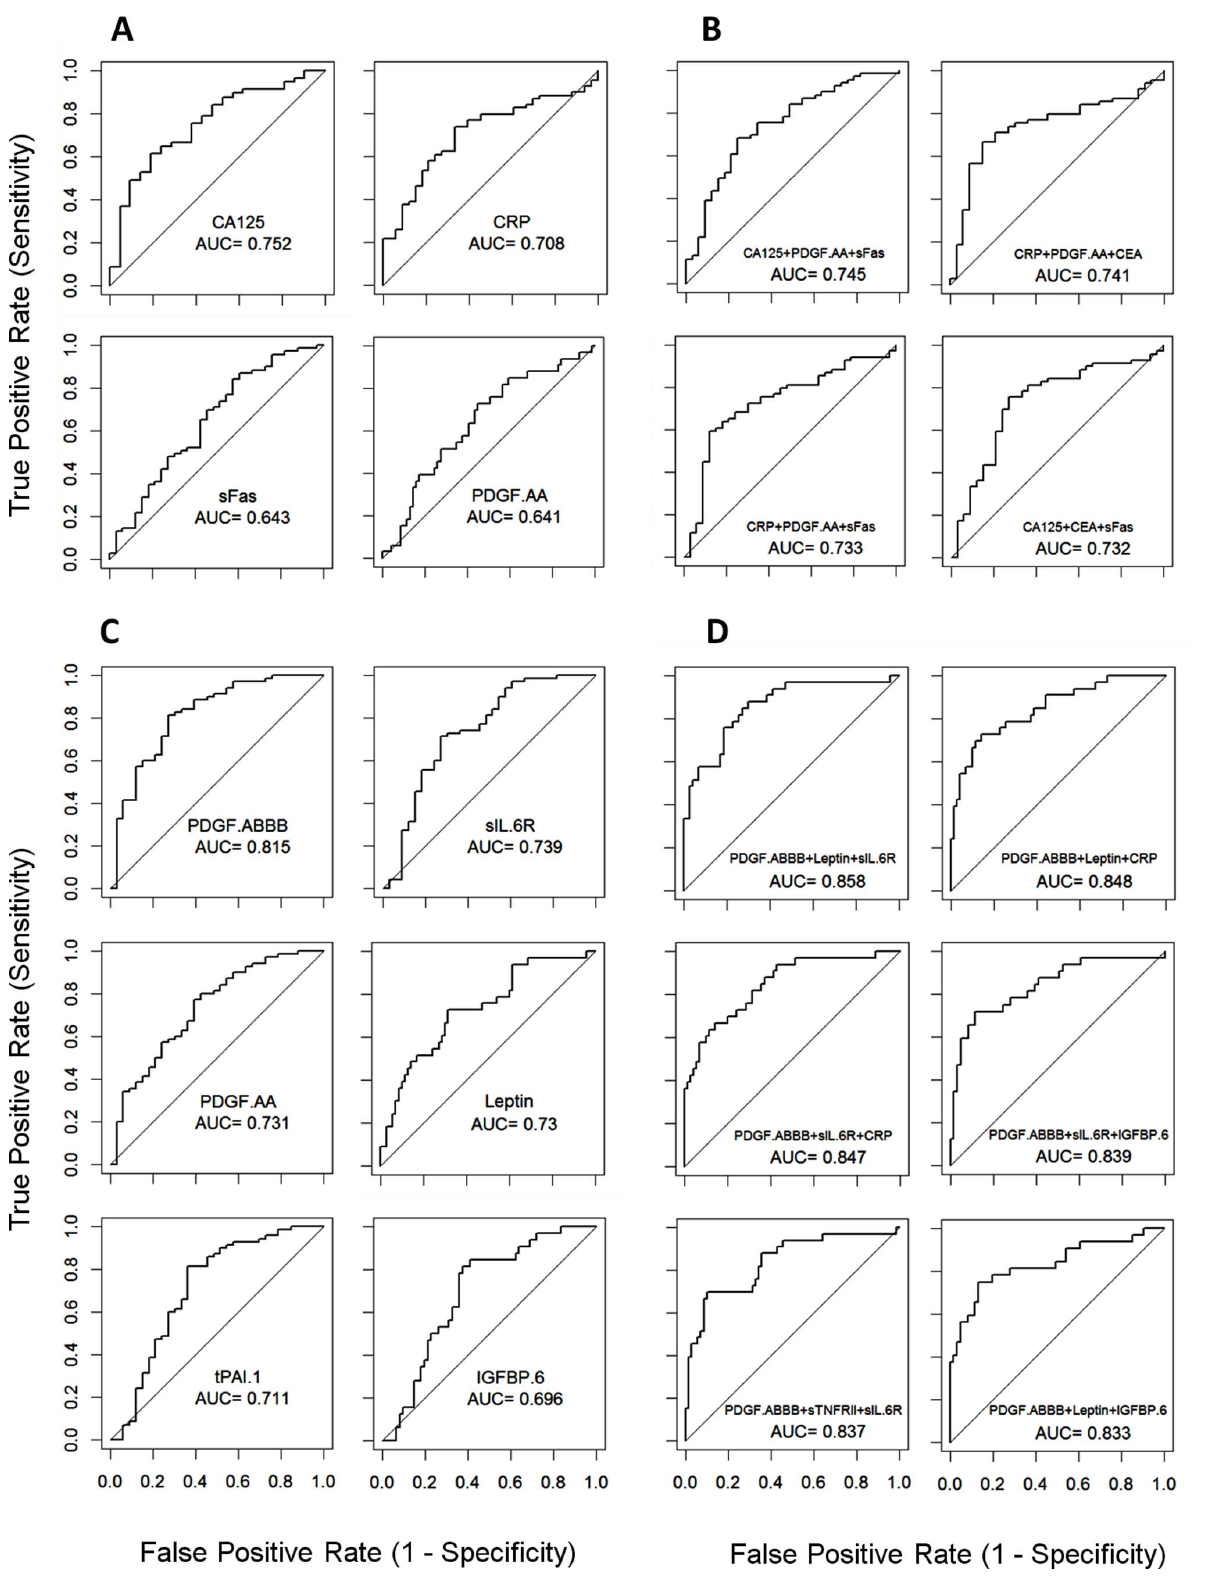
Figure 3. The ROC curves for the top molecules that distinguish samples at remission from samples with active cancer (A, B) or healthy controls (C, D). Results were shown for single proteins (A, C) and multi-marker models (B, D).